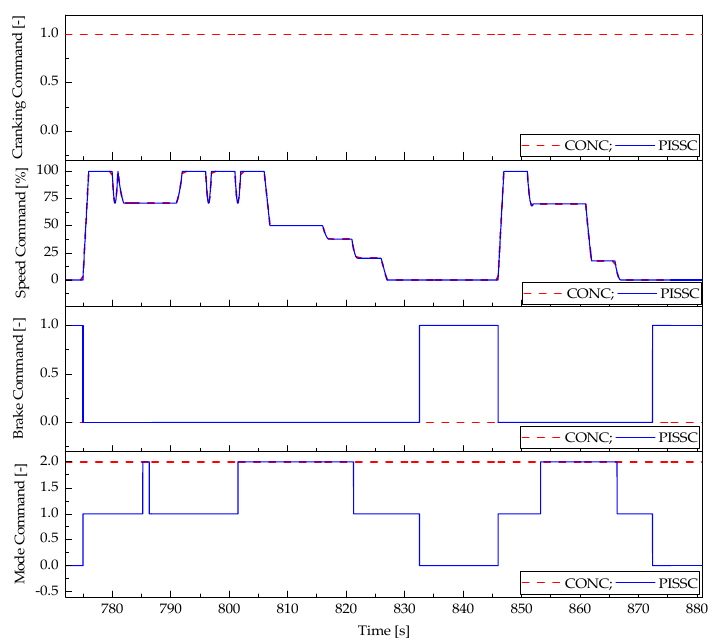
Figure 16. Simulated HMI and load signals from the 7th cycle—stage 16 to the 8th cycle—stage 15.